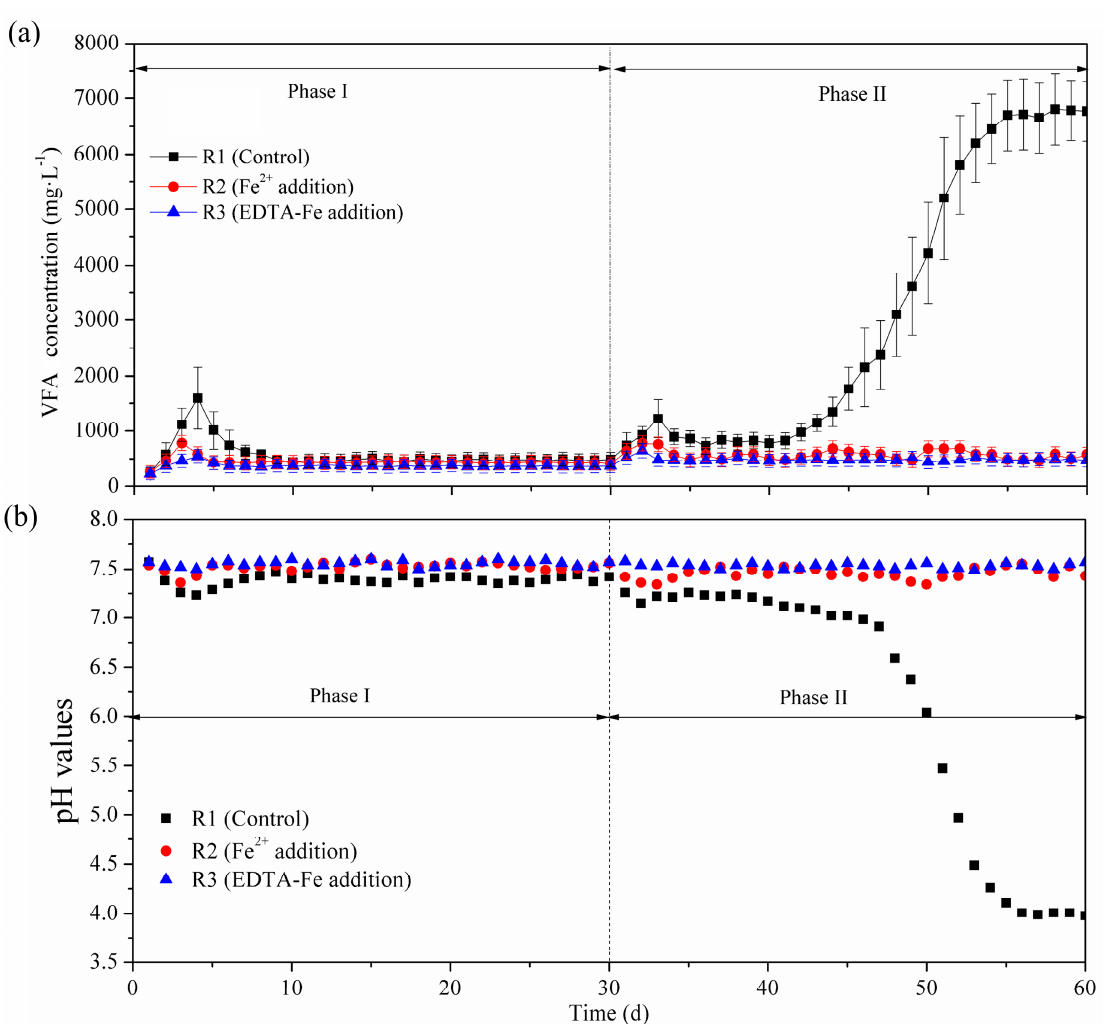
Figure 2. Changes in ( a ) volatile fatty acid (VFA) concentration and ( b ) pH with different additives and operating